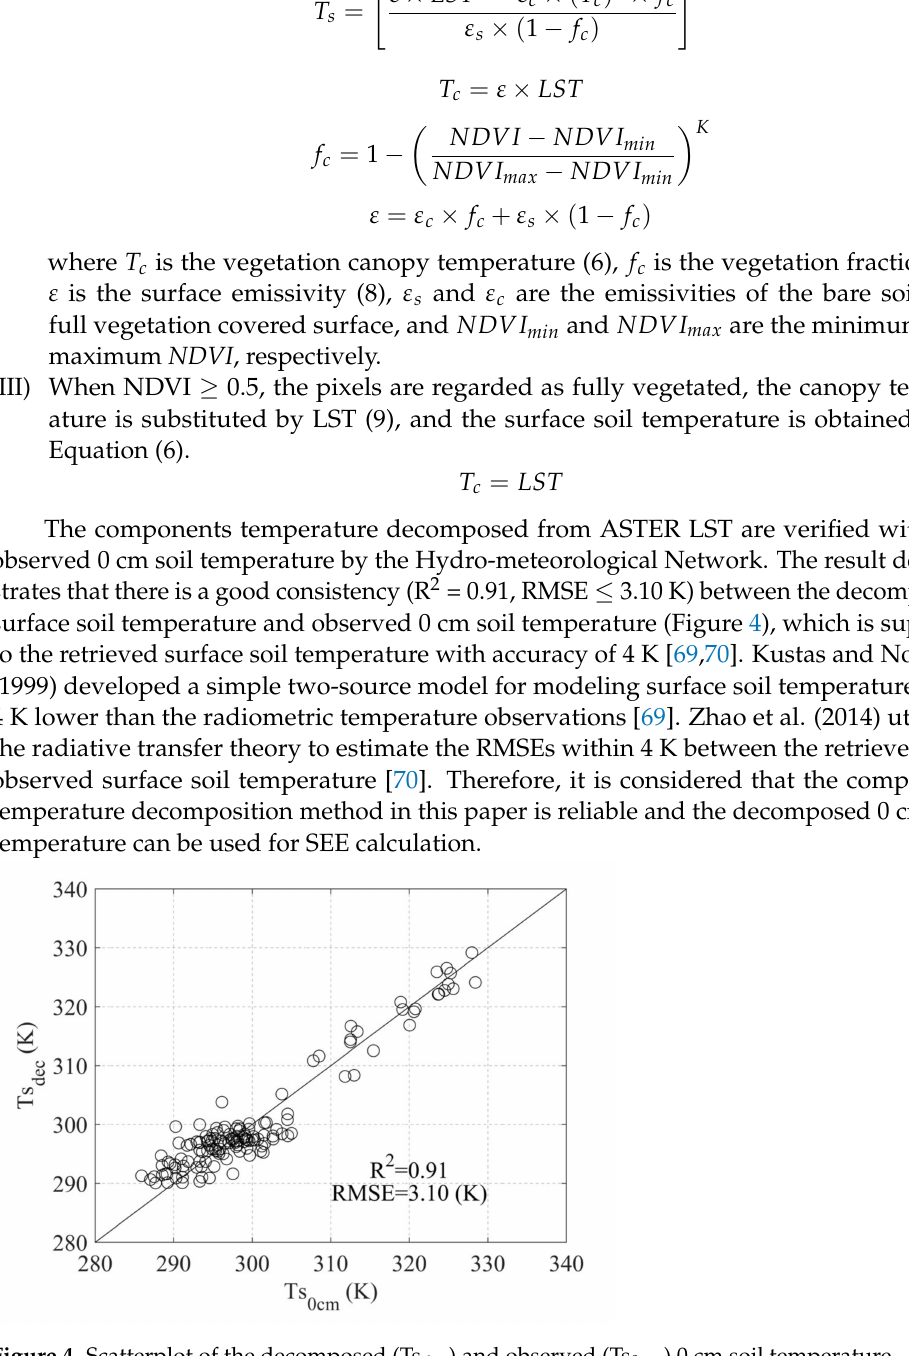
Figure 4. Scatterplot of the decomposed (Ts dec ) and observed (Ts 0cm ) 0 cm soil